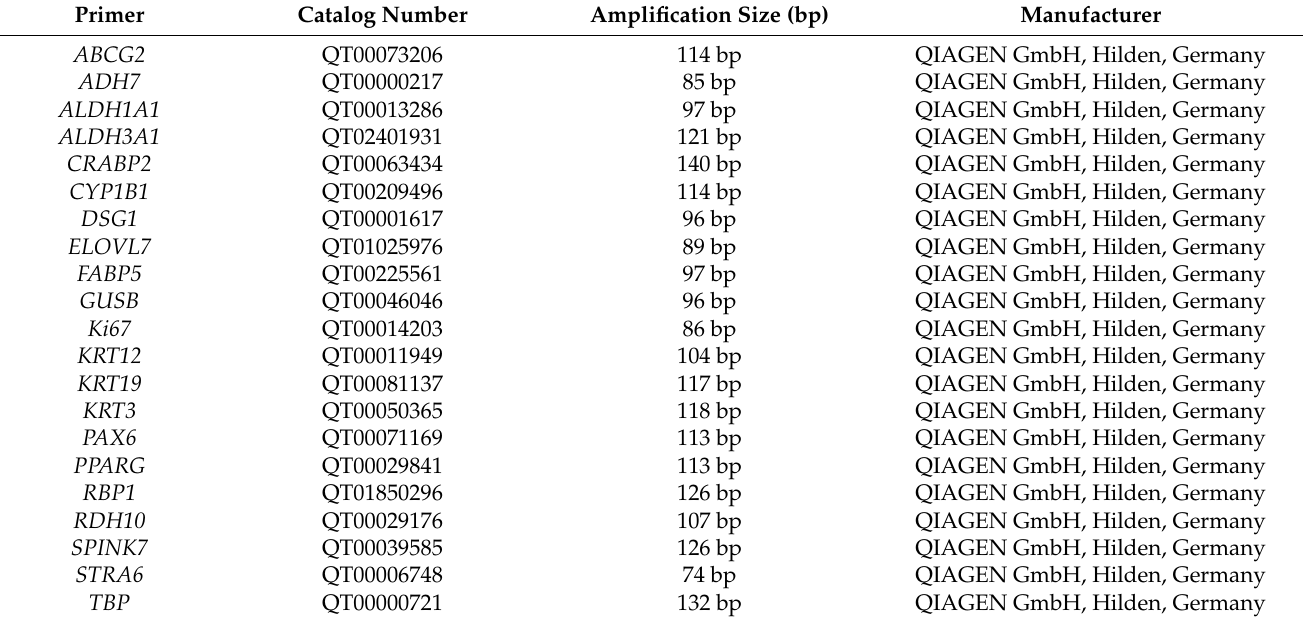
Table A1. qPCR primers used in our